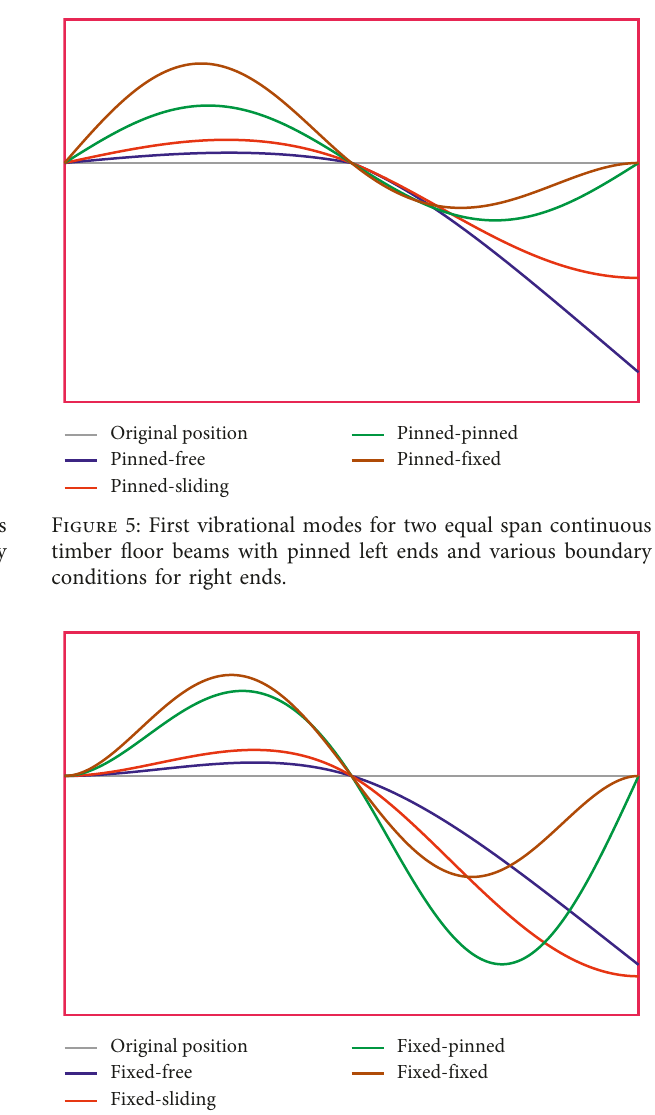
Figure 4: First vibrational modes for two equal span continuous timber floor beams with sliding left ends and various boundary conditions for right ends.